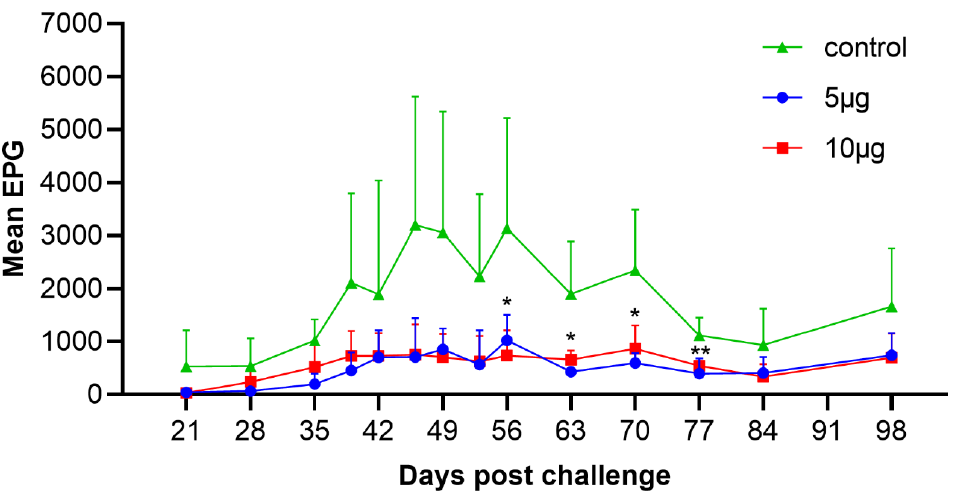
Figure 2. Dynamic range of fecal eggs per gram (EPG) in the trials. Goats vaccinated with adjuvant alone were served as the controls for those vaccinated with 5 μg and 10 μg protein groups. Mean group EPG (mean ± SD; adjuvant control, n = 4; 5 μg group, n = 3; 10 μg group, n = 5) was monitored at 14 time points (days 21 – 98 post-challenge infection). Statistical significance was determined using the one-way ANOVA, * p < 0.05 and ** p < 0.01.